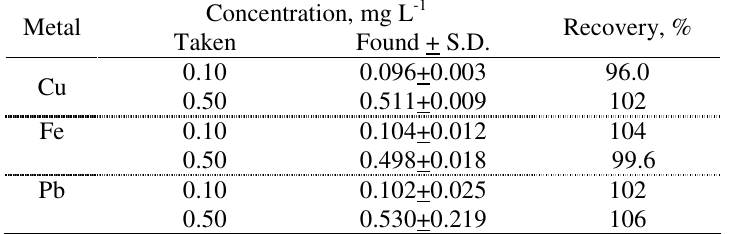
Table 5. Determination of Cu, Fe and Pb contents using the developed method ( n =